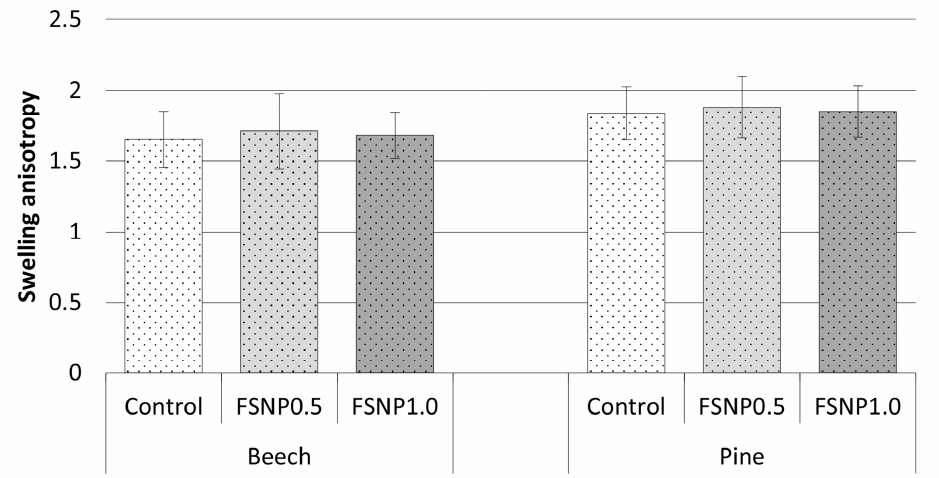
Figure 7. Swelling anisotropy of FSNP-modified beech and Scots pine wood (whiskers showing standard deviation of the results).